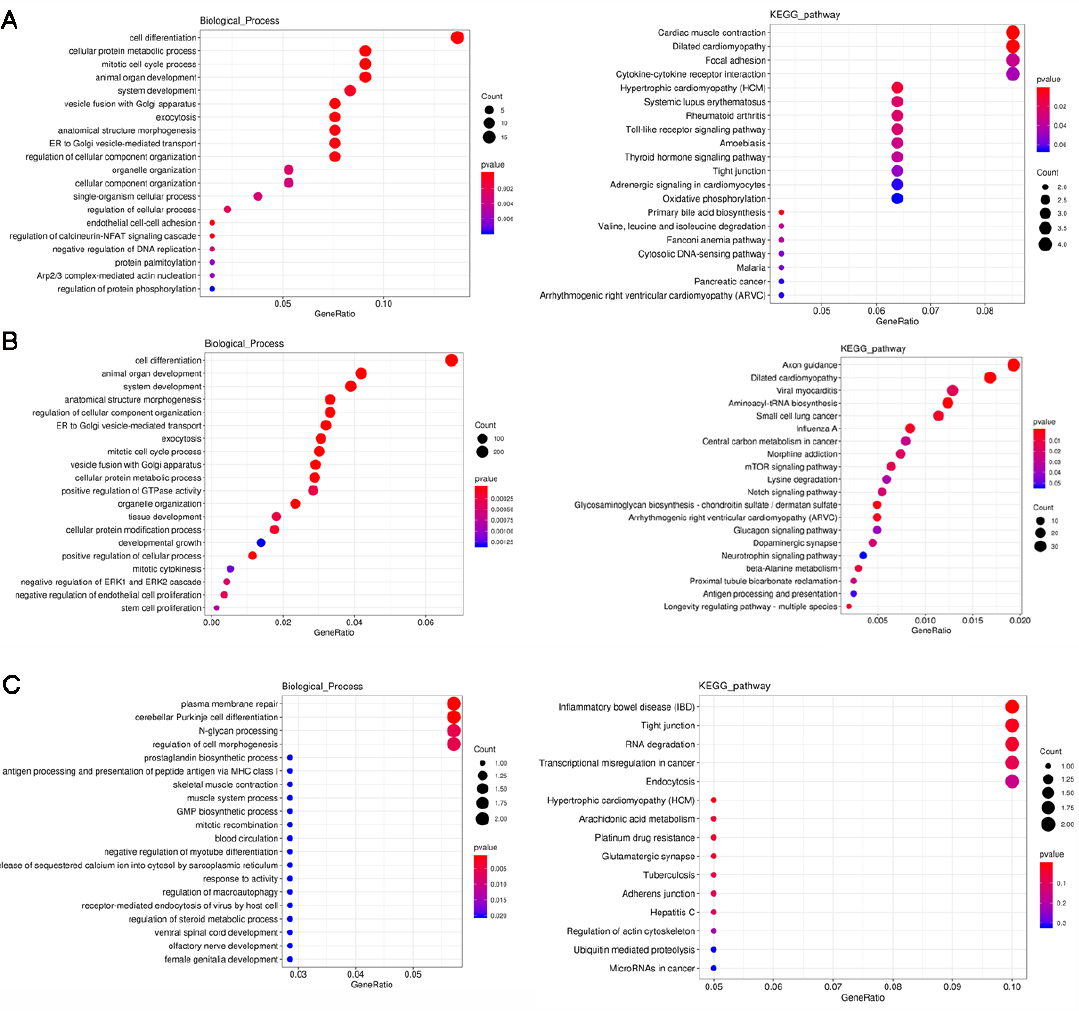
Figure 3. Gene ontology and pathway analysis of the DEGs and the potential target genes (PTGs) of DE miRNAs and circRNAs. ( A ) Gene ontology and pathway analysis of DEGs. ( B ) Gene ontology and pathway analysis of DE miRNA target genes. ( C ) Gene ontology and pathway analysis of the DE circRNA target genes.